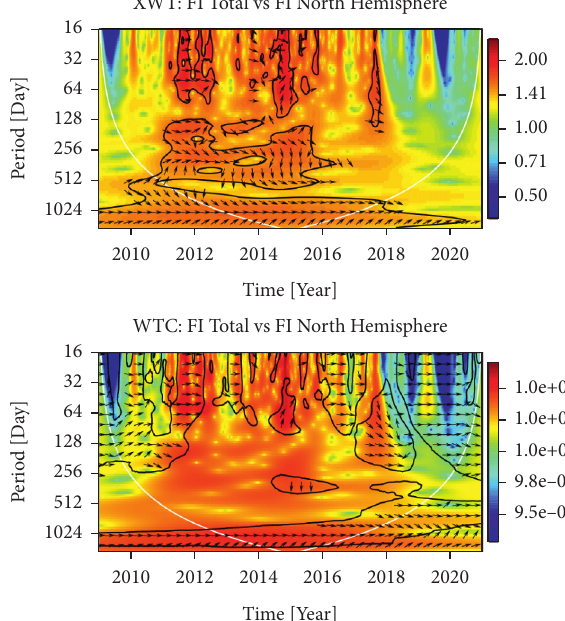
Figure 5: XWT (upper panel) and WTC (lower panel) spectrums between Northern and Southern Hemisphere FI data sets. The red color represents regions with the most significant interrelation, while blue colors show the lowest dependence between the selected time series. Periodicities obtained outside of the COI for all wavelet plots are usually not reliable. Arrows in the wavelet coherence plots represent the phase relations between the time series. A zero phase difference means that the two time series move together on a particular scale. Arrows point to the right/left when the time series are in phase (antiphase). Arrows pointing to the right-down or left- up indicate that the first variable is leading, while arrows pointing to the right-up or left-down show that the second variable is leading.